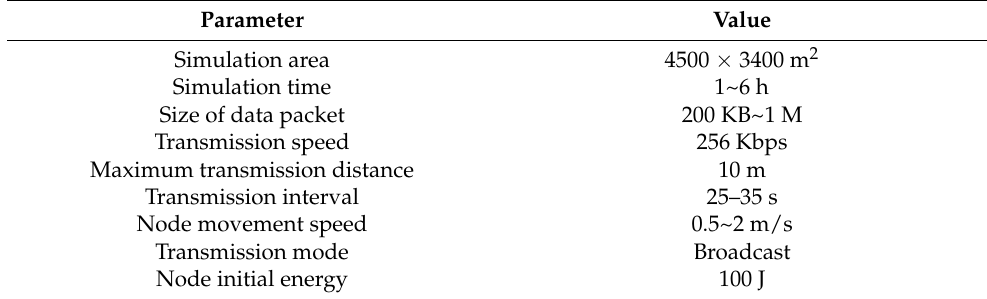
Table 1. Simulation